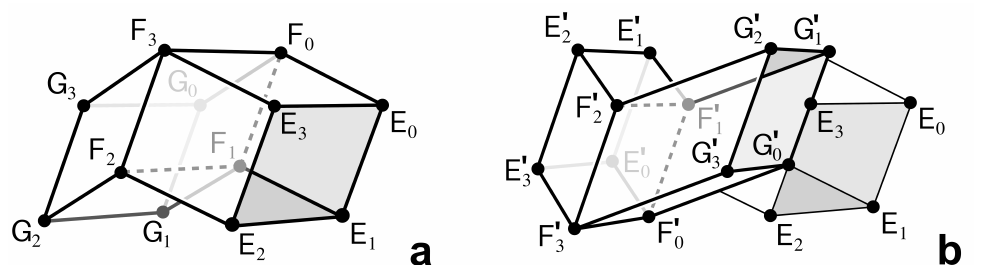
Figure 3. ( a ) The vertices in the first origami tube segment in the construction of an asymmetric zipper-coupled tube segments pair. ( b ) The vertices in the second origami tube segment in the construction of an asymmetric zipper-coupled tube segments pair. (Adapted from